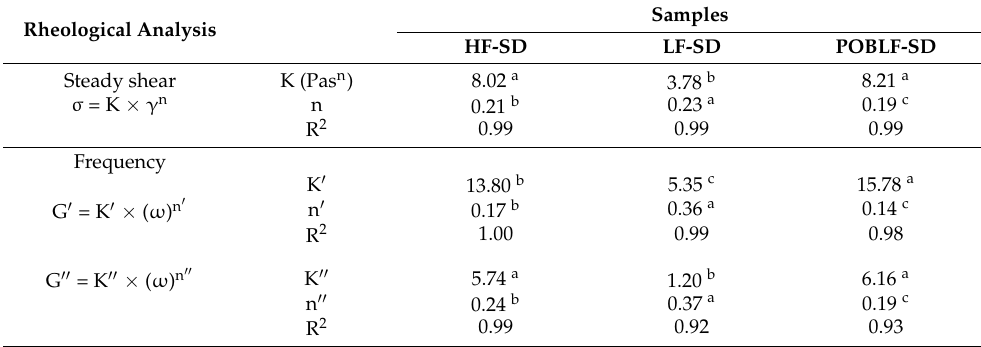
Table 5. The rheological properties, zeta potential, and particle size of HF-SD, LF-SD, and POBLF-SD. Rheological